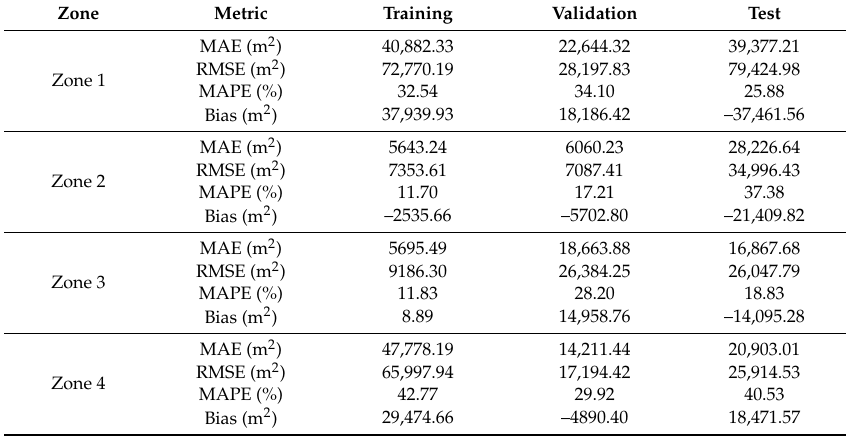
Table 9. Goodness-of-fit tests of an ANN (60-20-20 correspond to training, validation, and test, respectively) in prediction of wildfires surface larger than 30,000 m 2 in the 2000–2014 period.